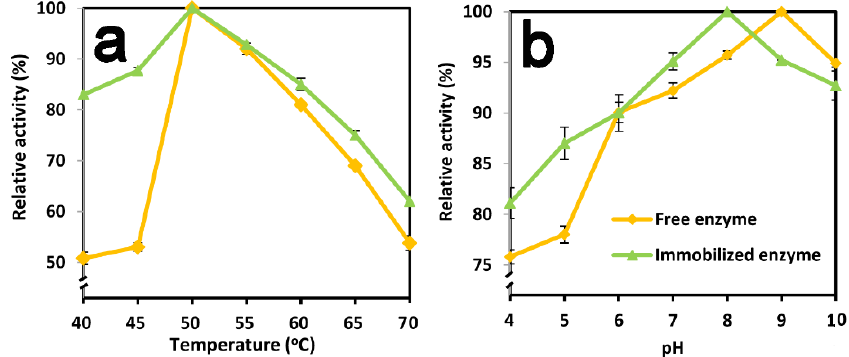
Figure 3. Effect of temperature and pH on the relative activity of free and immobilized TtTreS. Effect of temperature ( a ), and effect of pH ( b ). Table 2. The pH value and pH variation of free TtTreS and immobilized TtTreS. Type of